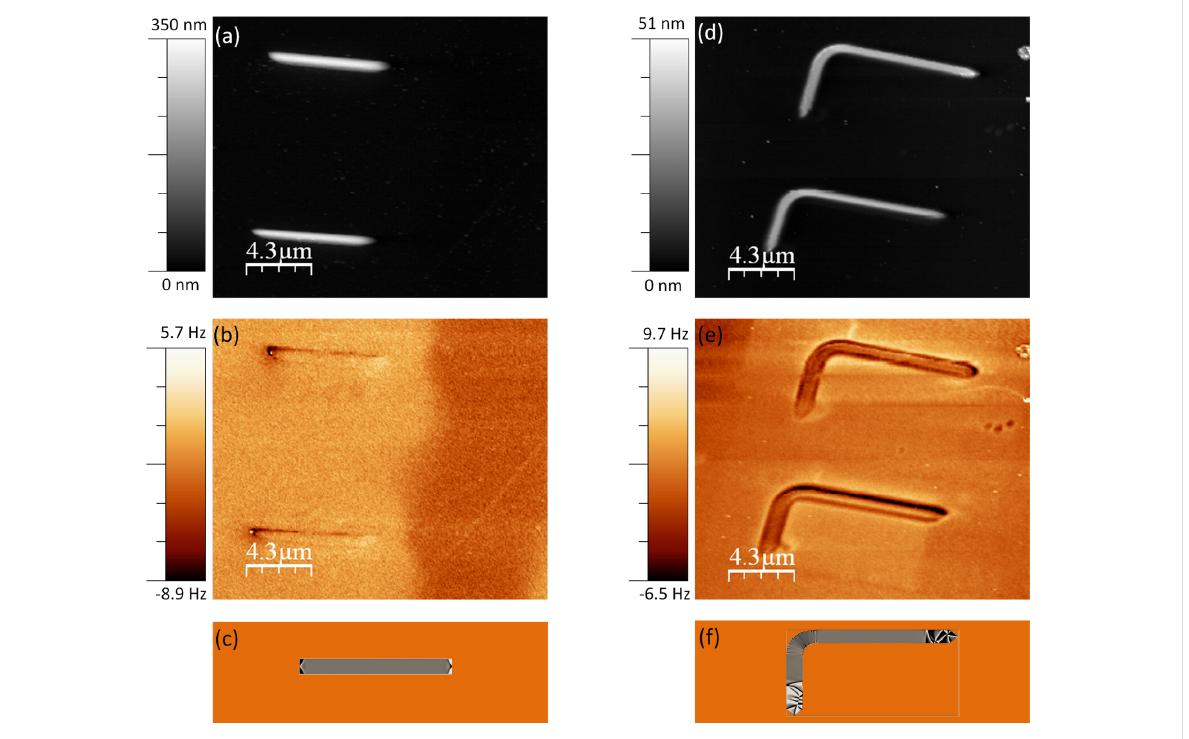
Figure 1: (a) Topography and (b) frequency shift images corresponding to the Co wires; (d) topography and (e) frequency shift images corresponding to the L-shape nanostructure. The frequency shift images were acquired at a retrace distance of 30 nm with V bias = 0V. Cantilever amplitude: (a–b) A = 5 nm and (d–e) A = 8.5 nm. Simulated maps of the magnetization distribution (divM) obtained by OOMMF code of the Co wire (c) and L - shape Co nanostructure (f) in the remanent state after saturation along the main axis of the